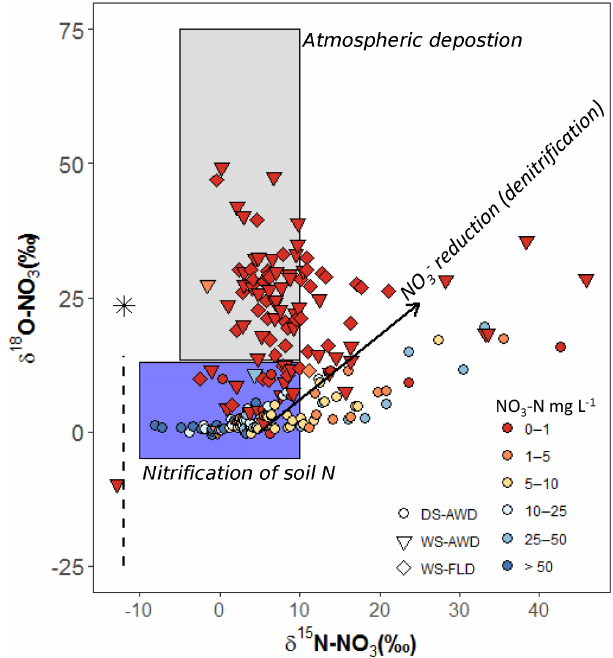
Figure 7. Relationship of δ 18 O-NO − to δ 15 N-NO − in pore wa- 3 3 ter samples of the three water management treatments (WS- FLD: water-seeding + conventional flooding; WS-AWD: water- seeding + alternate wetting and drying; DS-AWD: direct dry seed- ing + alternate wetting and drying). After Kendall and McDon- nell (2012). The black arrow represents the trajectory of NO − re- 3 duction effects. The black asterisk signifies the δ 18 O value atmo- spheric O 2 (25.3‰) while the dashed black line indicates the range of δ 18 O in soil water. δ 18 O − H 2 O was not directly measured in our study. We assumed a value of − 8 . 3‰ taken from an uncontained aquifer in the region by Rapti-Caputo and Martinelli (2009). The symbol colors indicate the concentration of NO − in each sample 3 (mgL − 1